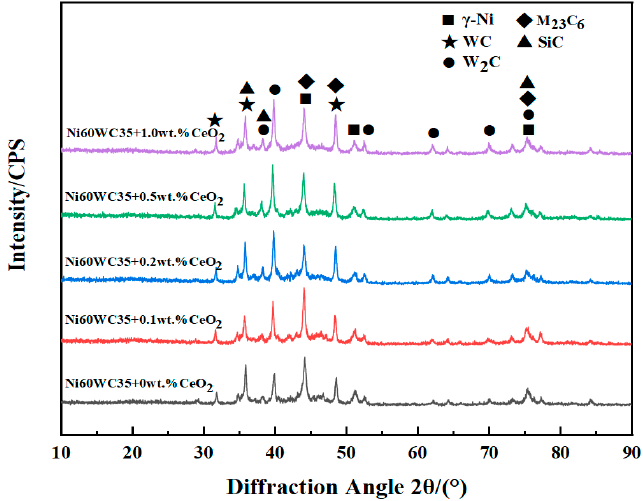
Figure 3. X-ray diffraction results of the Ni-based tungsten carbide cladding layer under different CeO 2 contents.